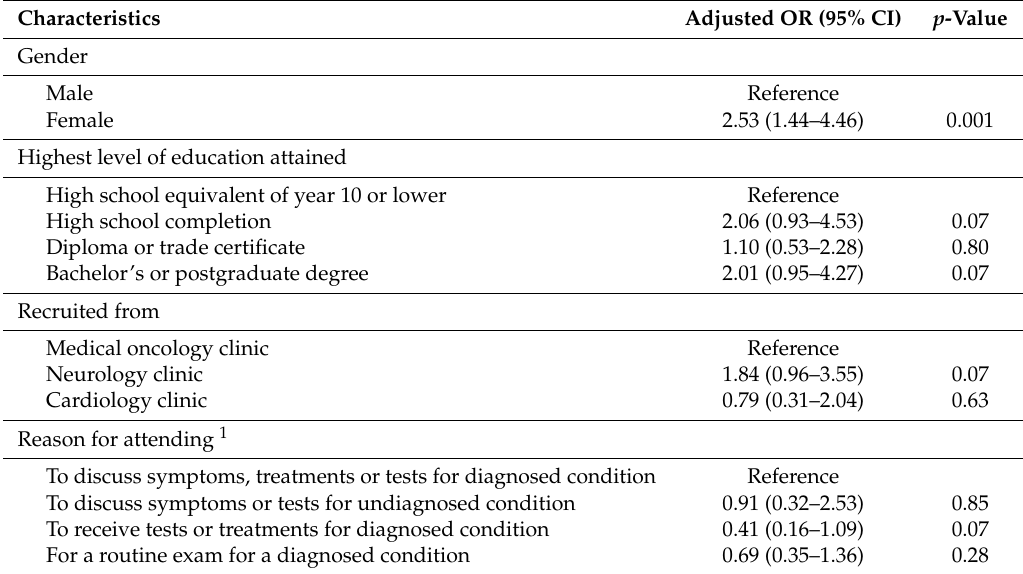
Table 7. Adjusted odds of selecting “Make it easier to contact the clinic”.